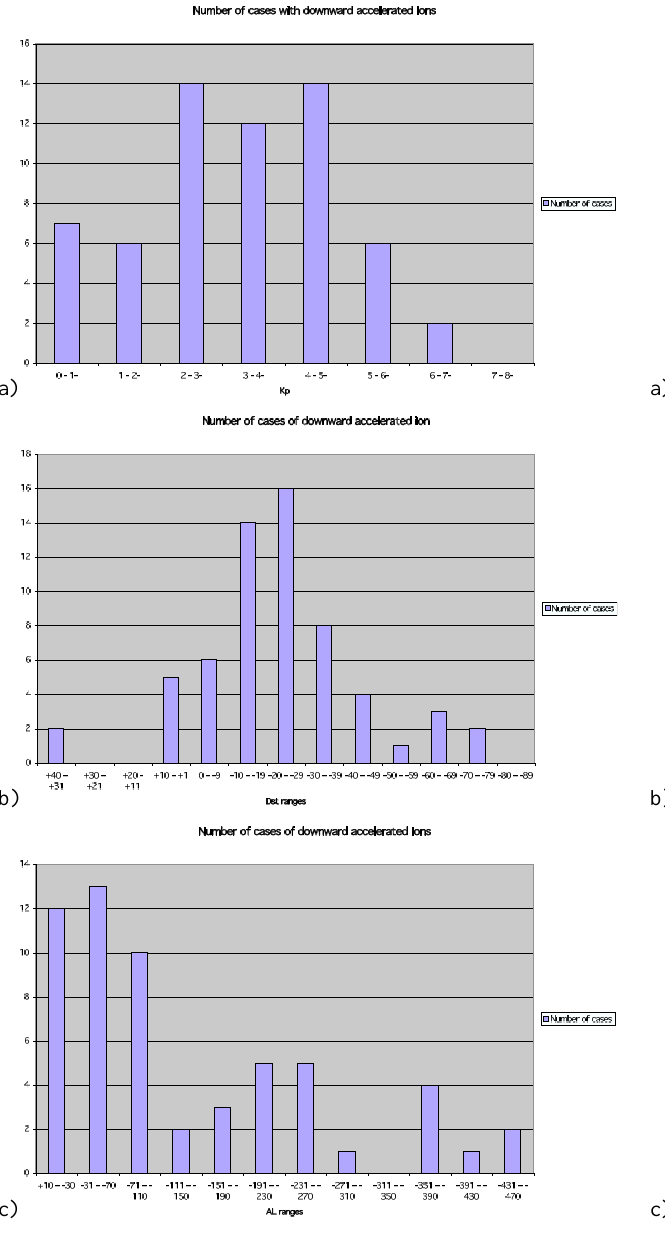
Fig.28. Distributions of index values over the same index value ranges as in Fig.27. The index values analysed are those for the months of May and September 1993, which were the first and the last months, respectively, of the period in which the ion precipita- tion events in Fig.27 occurred. (a) Distribution of K p value; (b) Distribution of Dst values; (a) Disribution of AL